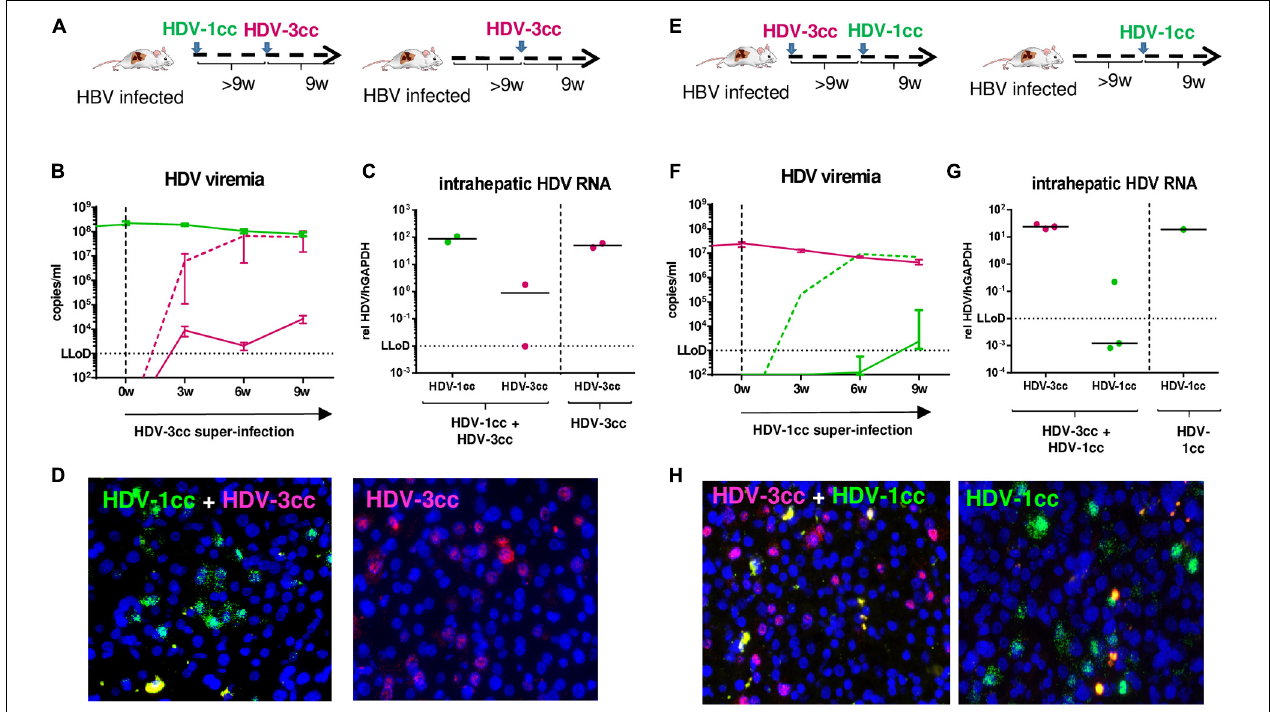
FIGURE 5 | HDV in chronic HBV-infected mice sequentially super-infected with HDV-1cc and HDV-3cc. (A) Experimental setting (first HDV-1cc, then HDV-3cc; control mice were super-infected with HDV-3cc only). (B,C) qRT-PCR measurements (genotype specific HDV primers/probe for HDV-1 and HDV-3 were used) of serum HDV RNA (quantification with cell culture derived RNA standard) at different time-points (B) and liver HDV RNA (normalized to housekeeping gene hGAPDH) at the end of experiment (C) . HDV-1cc RNA levels are depicted in green (line or dots) and HDV-3cc RNA levels in red (line or dots). The dashed red line shows HDV viremia in control mice (HDV-3cc only). Results are expressed as median ± range (B) , the bar shows median levels (C) . (D) RNA in situ hybridization (RNAScope) staining of HDV-1cc (green) and HDV-3cc AG HDV RNA (red) in HDV-1cc/HDV-3cc sequential super-infected ( left ) and HDV-3cc control mice ( right ) at the end of the experiment. Nuclei are stained with dapi (blue). (E) Experimental setting (first HDV-3cc, then HDV-1cc; control mice were super-infected with HDV-1cc only). (F,G) qRT-PCR measurements (genotype specific HDV primers/probe for HDV-1 and HDV-3 were used) of serum HDV RNA (quantification with cell culture derived RNA standard) at different time-points (F) and liver HDV RNA (normalized to housekeeping gene hGAPDH) at the end of experiment (G) . HDV-1cc RNA levels are depicted in green (line or dots) and HDV-3cc RNA levels in red (line or dots). The dashed green line shows HDV viremia in control mice (HDV-1cc only). Results are expressed as median ± range (F) , the bar shows median levels (G) . (H) RNA in situ hybridization (RNAScope) staining of HDV-1cc (green) and HDV-3cc AG HDV RNA (red) in HDV-3cc/HDV-1cc sequential super-infected ( left ) and HDV-1cc control mice ( right ) at the end of the experiment. Nuclei are stained with dapi